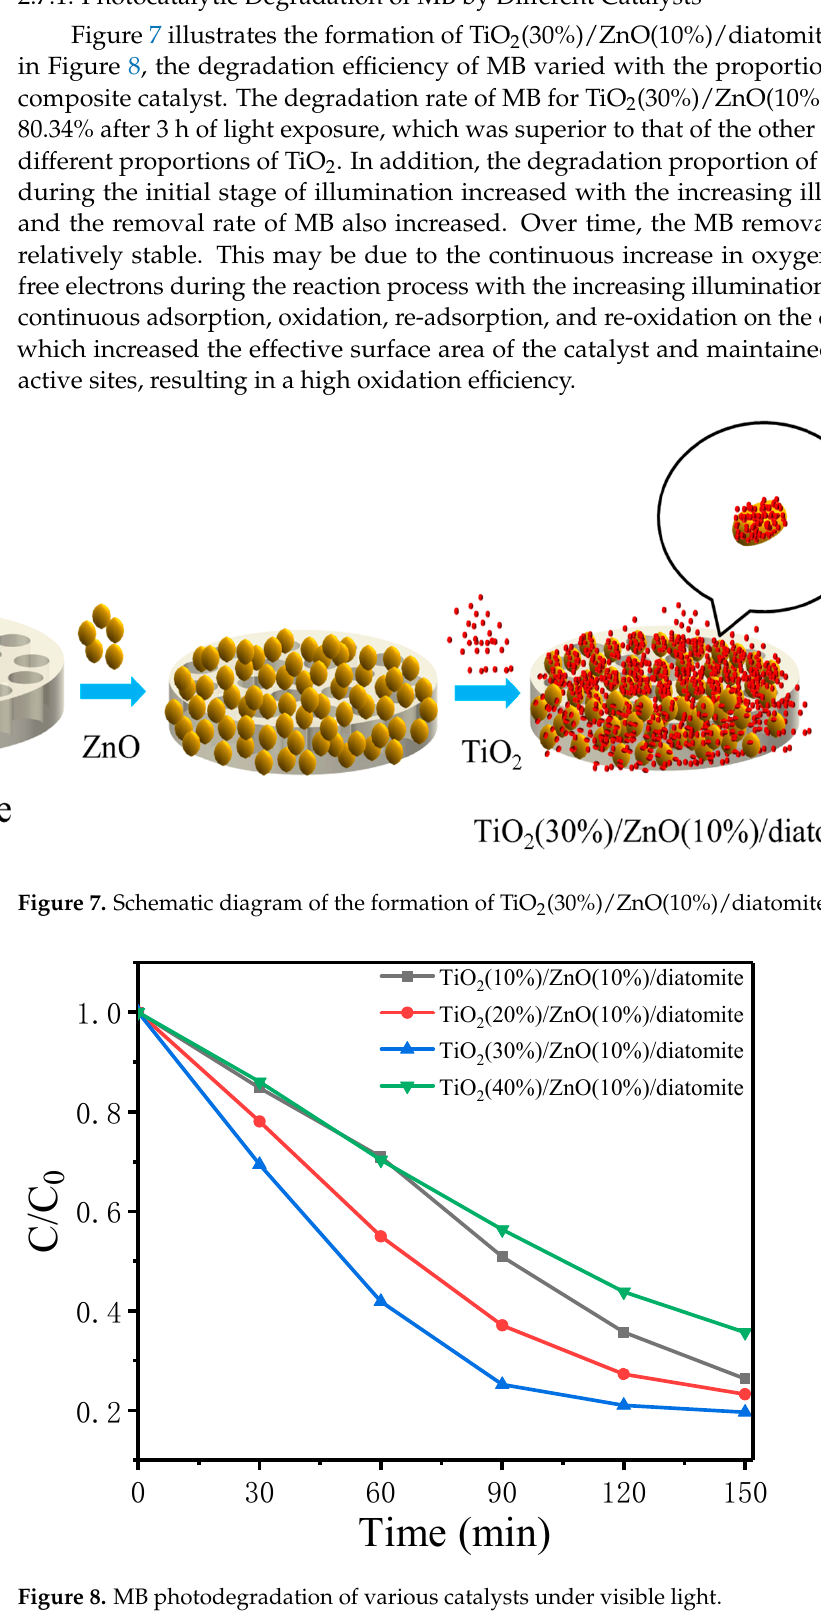
Figure 6. PL spectra of diatomite, ZnO, ZnO(10%)/diatomite, and TiO 2 (30%)/ZnO(10%)/diatomite.